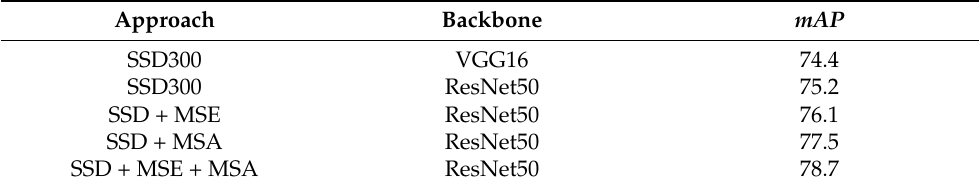
Table 4. Ablation experiments.